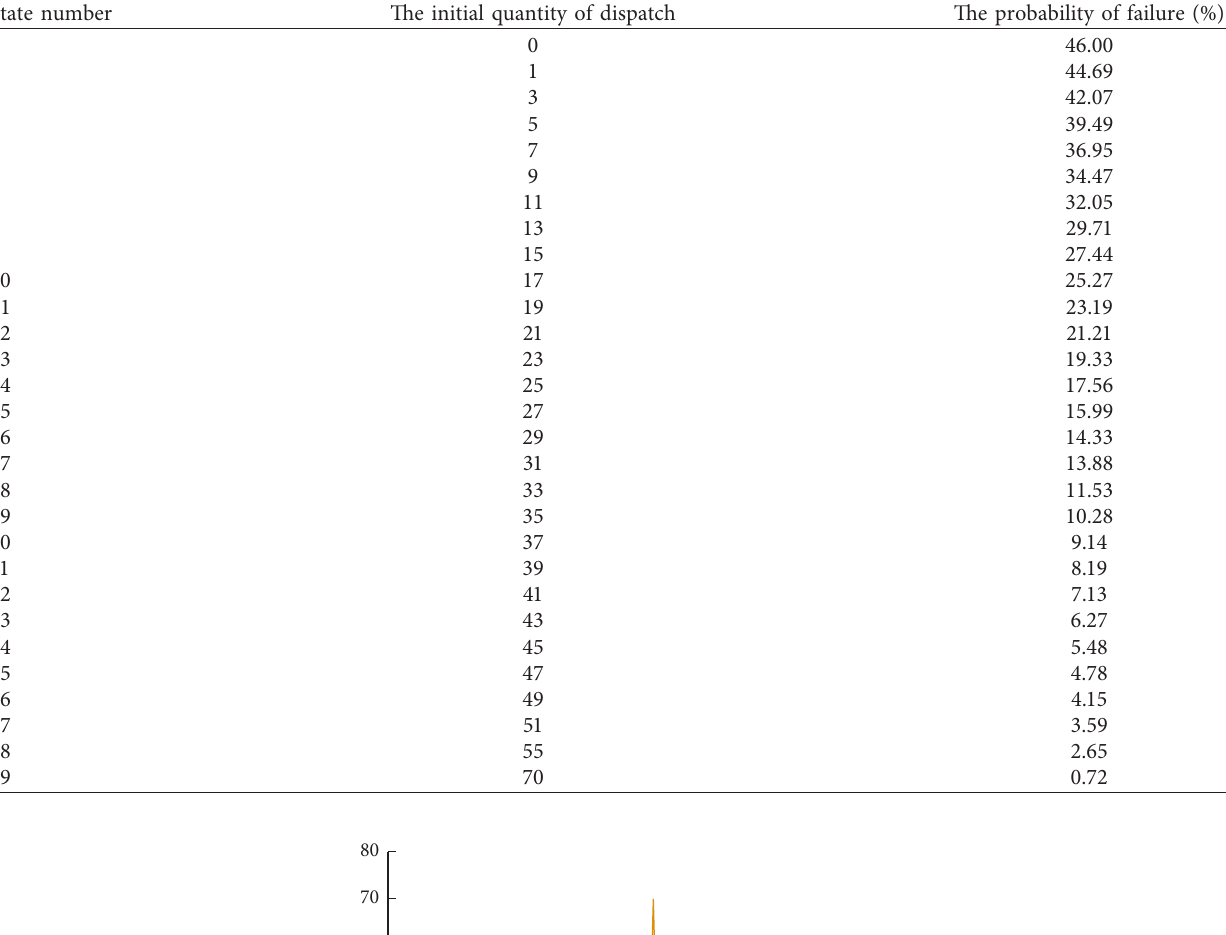
Table 5: The failure probability of system failure at different dispatch quantities within the 27th dispatch area.